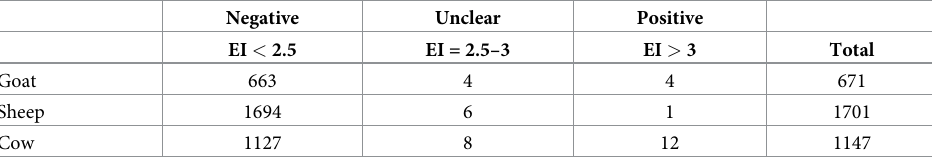
Table 1. Results of the Elisa diagnostic based on the Elisa index (EI) values obtained on individual sera from goats, sheep and